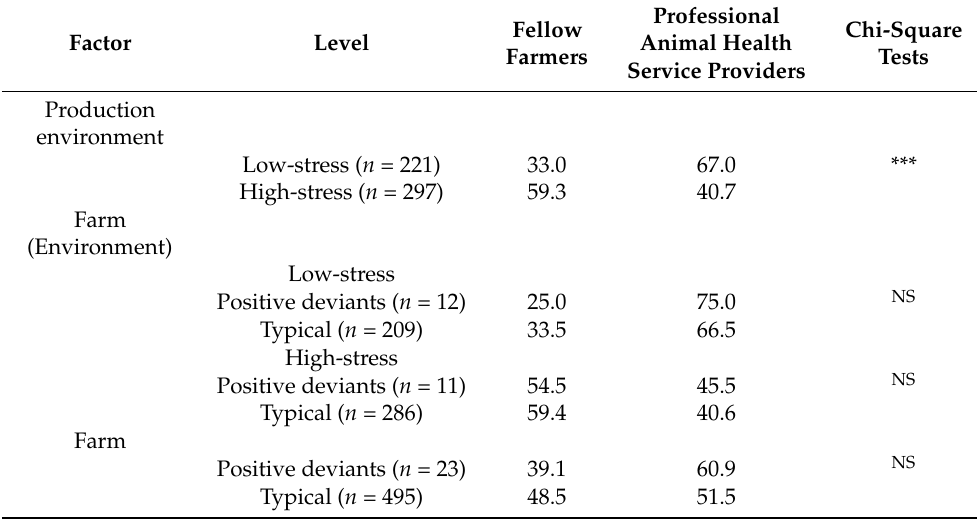
Table 6. Distribution frequency (percentage) of animal health service providers sourced by positive deviant and typical farms under contrasting stressful